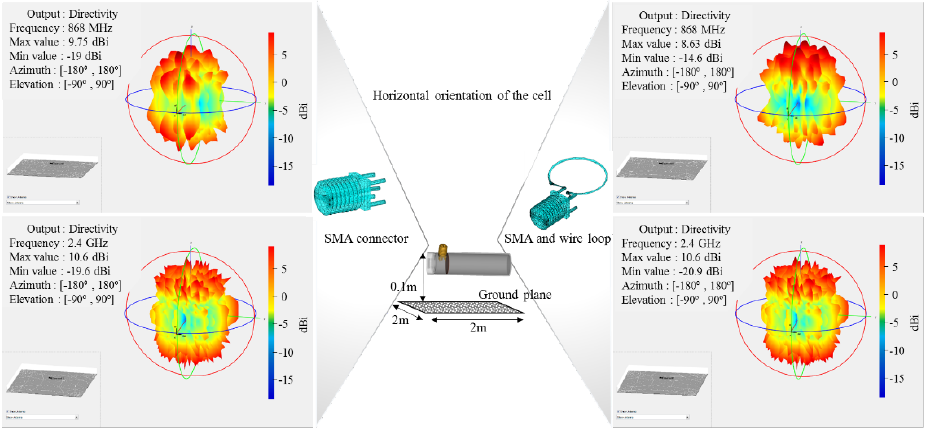
Figure 10. MATLAB 3D radiation pattern simulation for the cell’s shell radiative structure integrat- ing the SMA and the wired loop for 868 MHz and 2.4 GHz over the ground plane in a horizontal orientation.